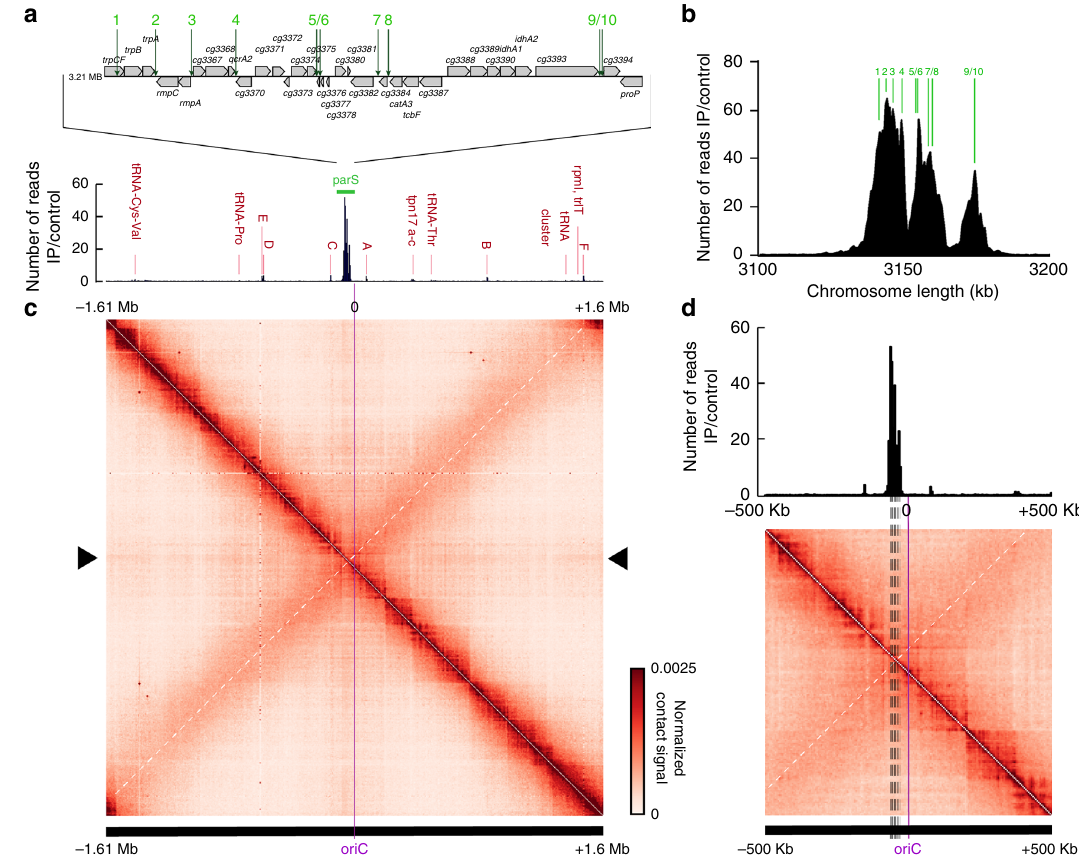
Fig. 1 Chromosome organization hub at oriC domain in C. glutamicum . a Top: genomic region including ten parS sites of C. glutamicum with 16 bp consensus sequences. Below: ChIP-seq data on ParB-mCherry DNA-binding protein con fi rm parS sites shown above. Exponentially growing C. glutamicum parB::parB-mCherry cells (CBK006) were used for in vivo anti-mCherry ChIP-seq experiments. Shown is the ratio of ChIP signal relative to the input (fold- enrichment IP/control) in 5 Kb bins in linear scale along the chromosome with an x -axis centered at oriC . Red labels indicate minor enrichment signals at highly transcribed regions, such as rRNA operons (letters A – F). b ParB-ChIP-seq enrichment encompassing 3.1 – 3.2 Mb genomic region; parS sites 1 – 10